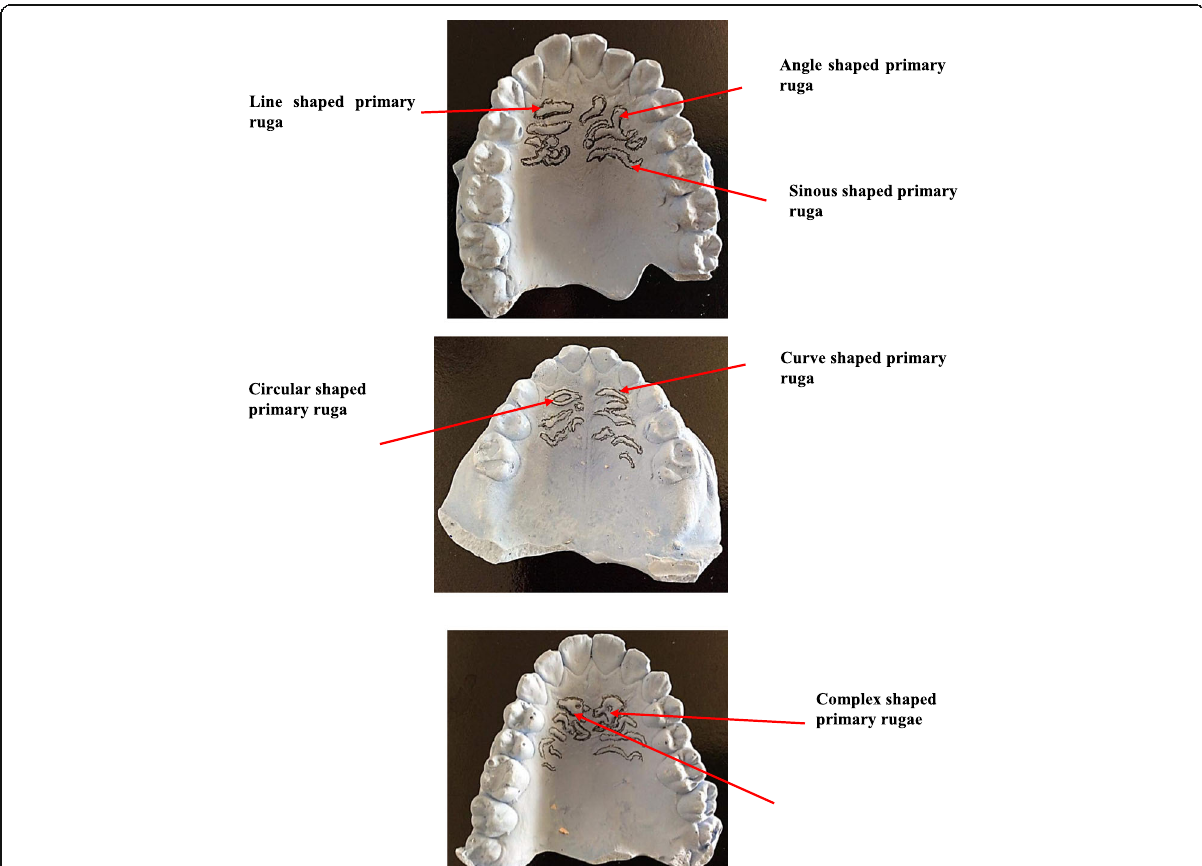
Fig. 1 Palatal impressions photographs showing different rugae patterns. (Line, Angled, Sinous, Circular, Curved & Complex